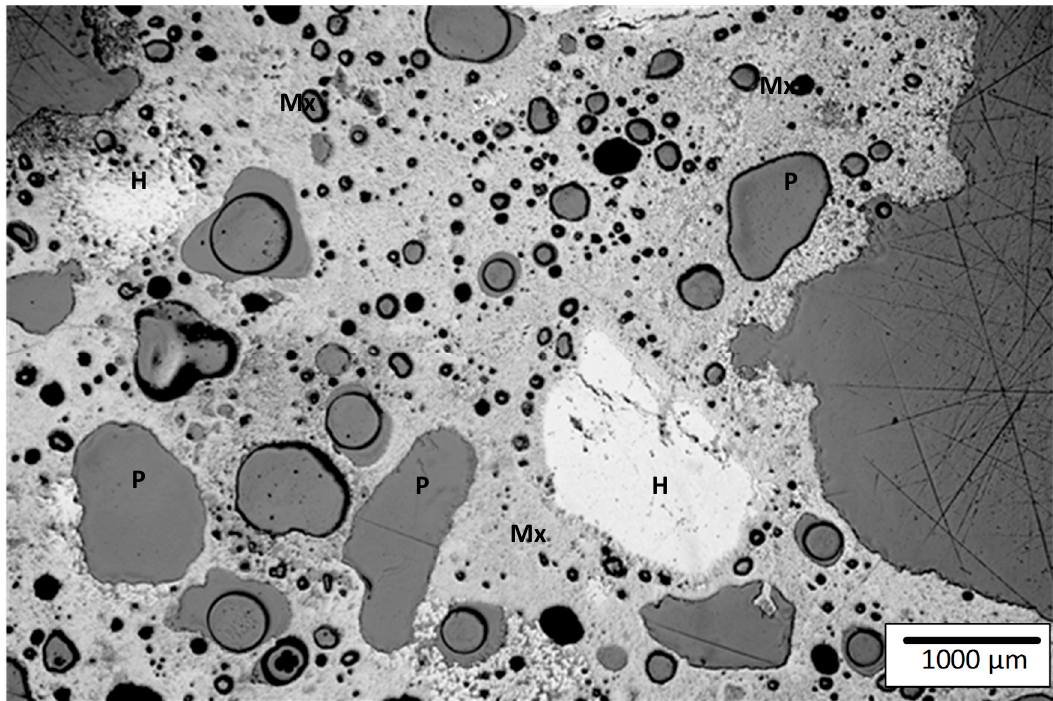
Figure 9. Polished cross section of an industrial sinter (Light Optical Microscope) (H—Hematite, P—Pores, Mx—Fine Multi-phase matrix material).